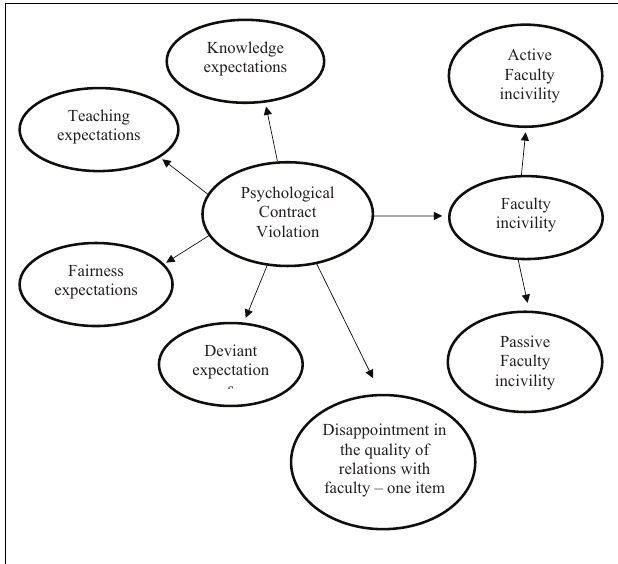
FIGURE 1 | Research model.